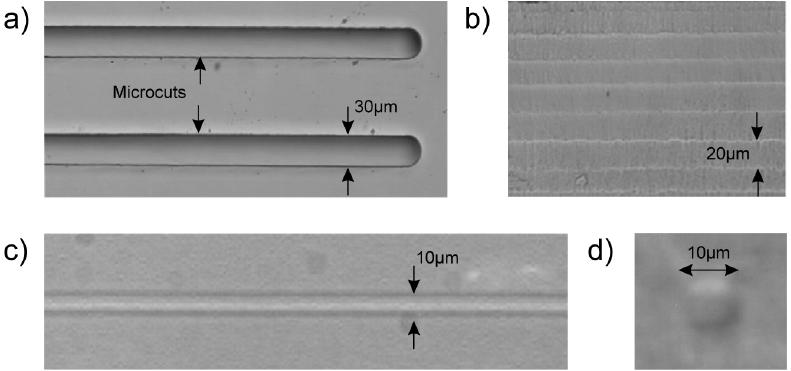
Figure 3. Microscope pictures of: (a) fused silica substrate with two cuts made by irradiation and subsequent etching in HF, (b) vertical wall of one of these cuts, (c) top view of an optical waveguide written with the femtosecond laser inside the substrate and (d) end view of the